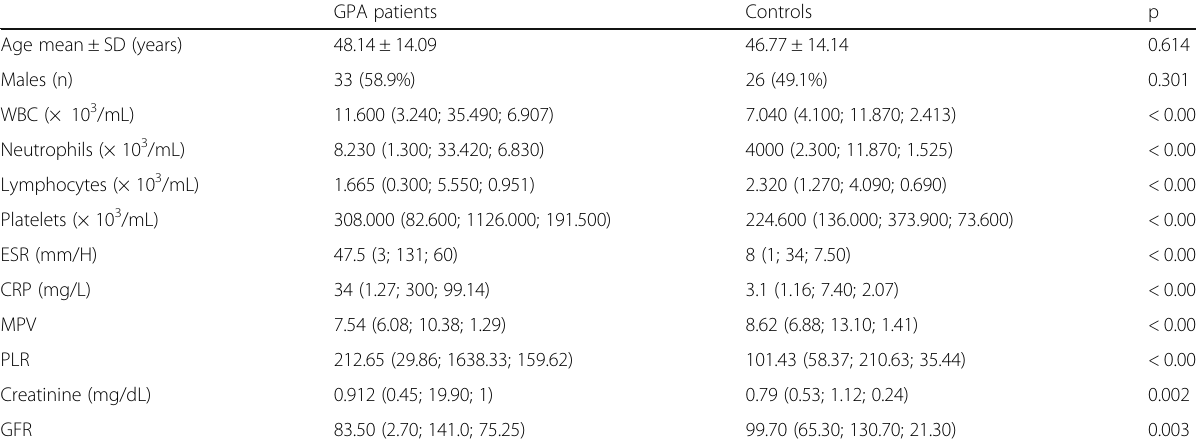
Table 1 Clinical characteristics and laboratory findings of the study population GPA patients Controls